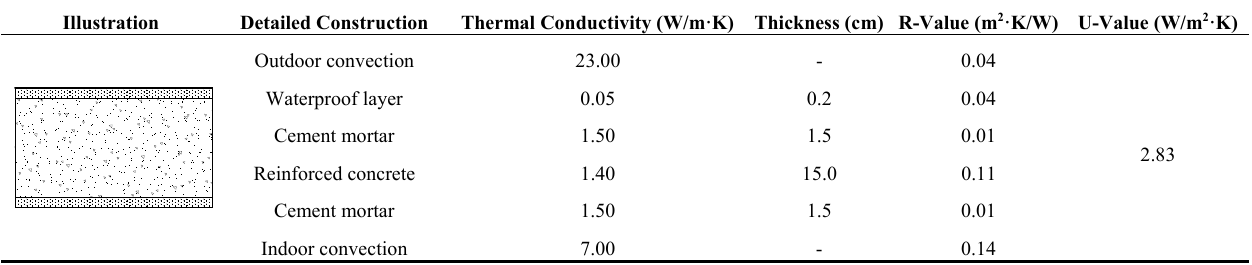
Table 2. Detail of the flat-roof RC and thermal properties of each layer of material [5].